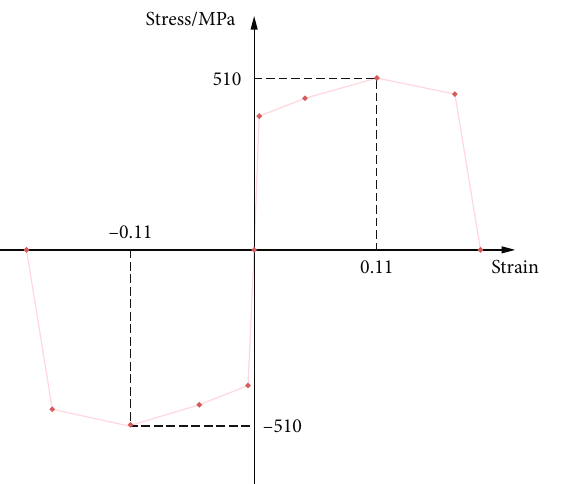
Figure 3: Structural nonlinear constitutive relation.